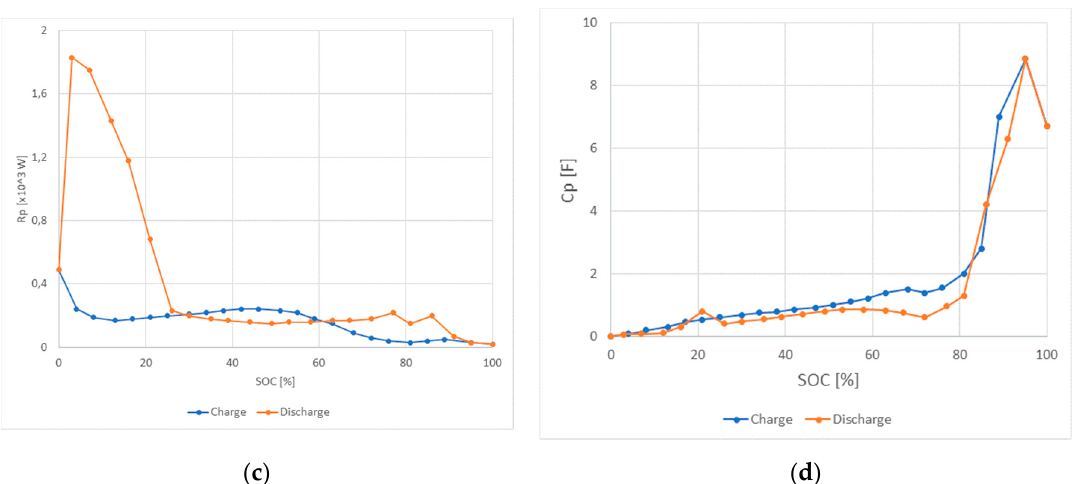
Figure 5. Model parameters of lithium-sulphur battery: ( a ) open circuit voltage V OC , ( b ) internal resistance R s , ( c ) polarization resistance R p , ( d ) polarization capacitance C p versus SOC for charging and discharging processes.